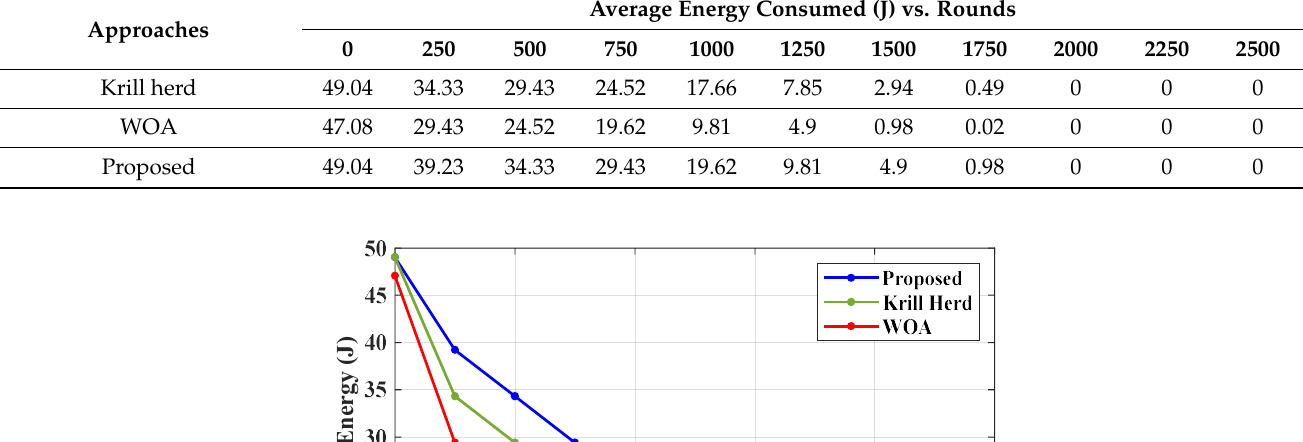
Table 3. Average residual energy consumption of the proposed ASFO algorithm. Average Energy Consumed (J) vs. Rounds